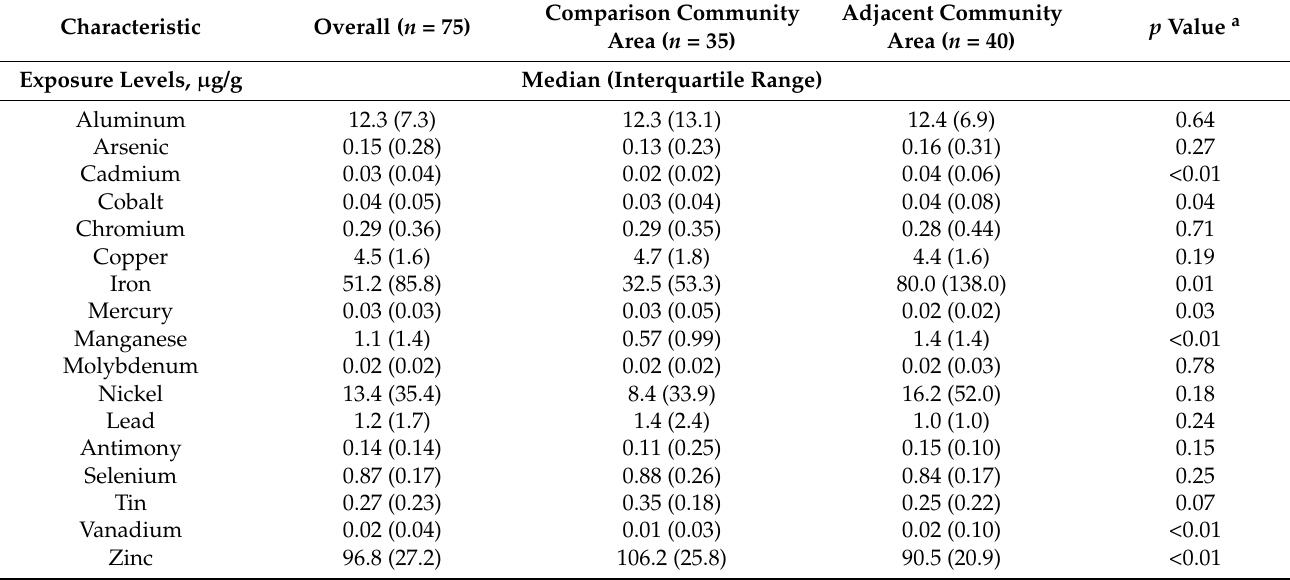
Table 2. Distribution of toenail metal concentrations, overall and by community area ( n =